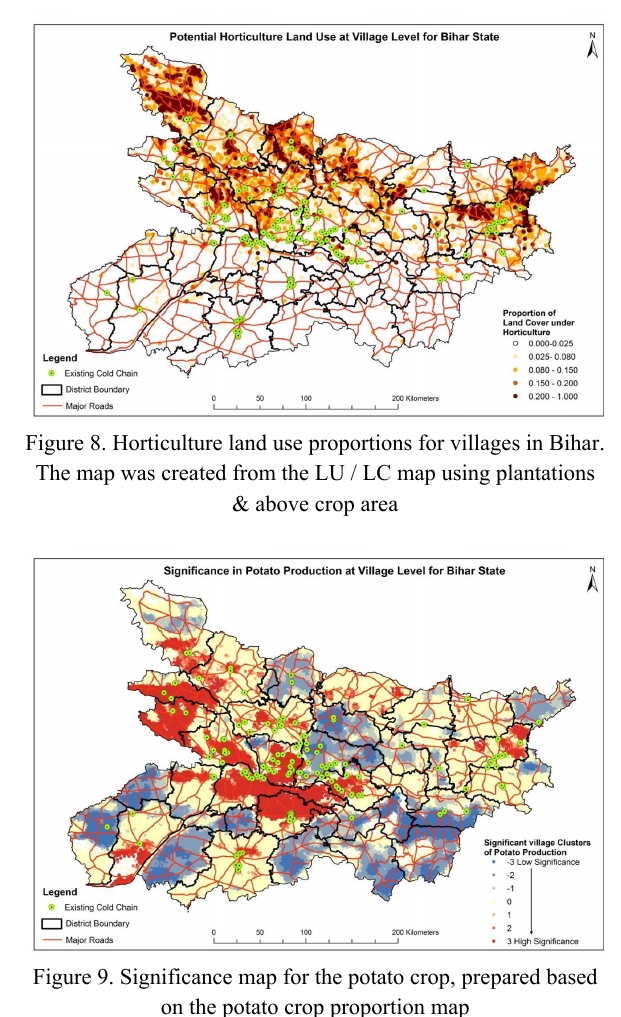
Figure 7. Potato crop area proportions for villages in Bihar. The map was created from remote sensing-based estimates.